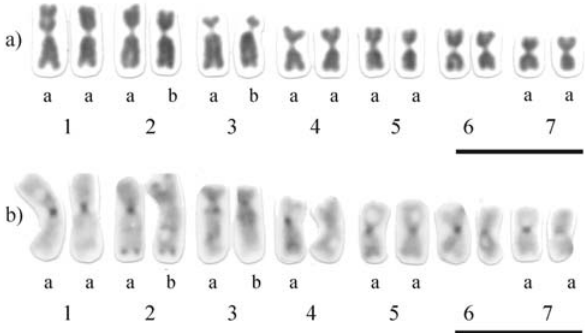
Figure 3 - Conventionally stained (a) and C-banded (b) triploid karyo- typesof Dolichoplanacarvalhoi (2n=3x=21).Bar10 μ m.Thelettersun- der the chromosomes represent their variants.